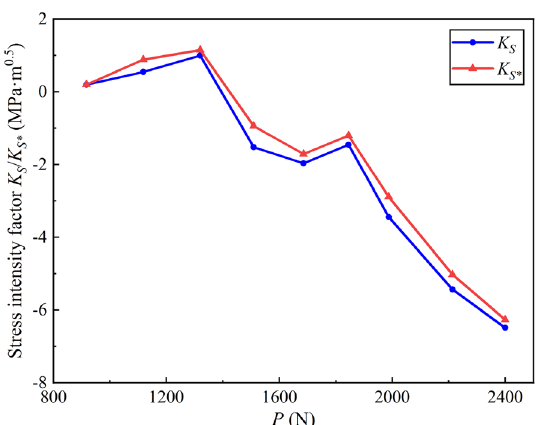
Figure 12 Variation trend of stress intensity factors K S and K S * with load